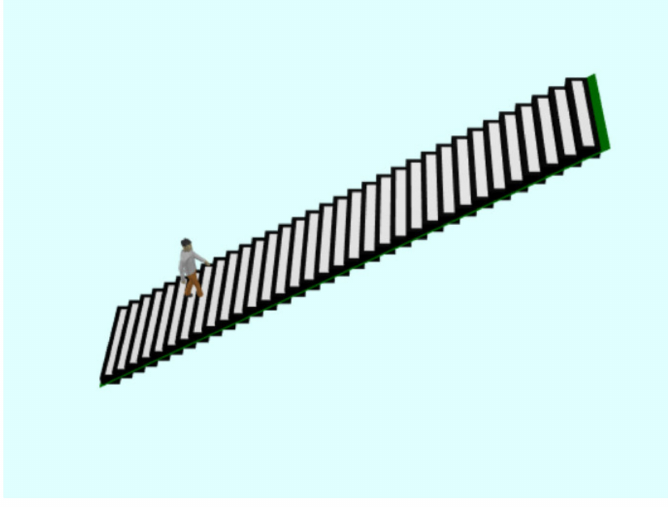
Figure A2. The scenario of test